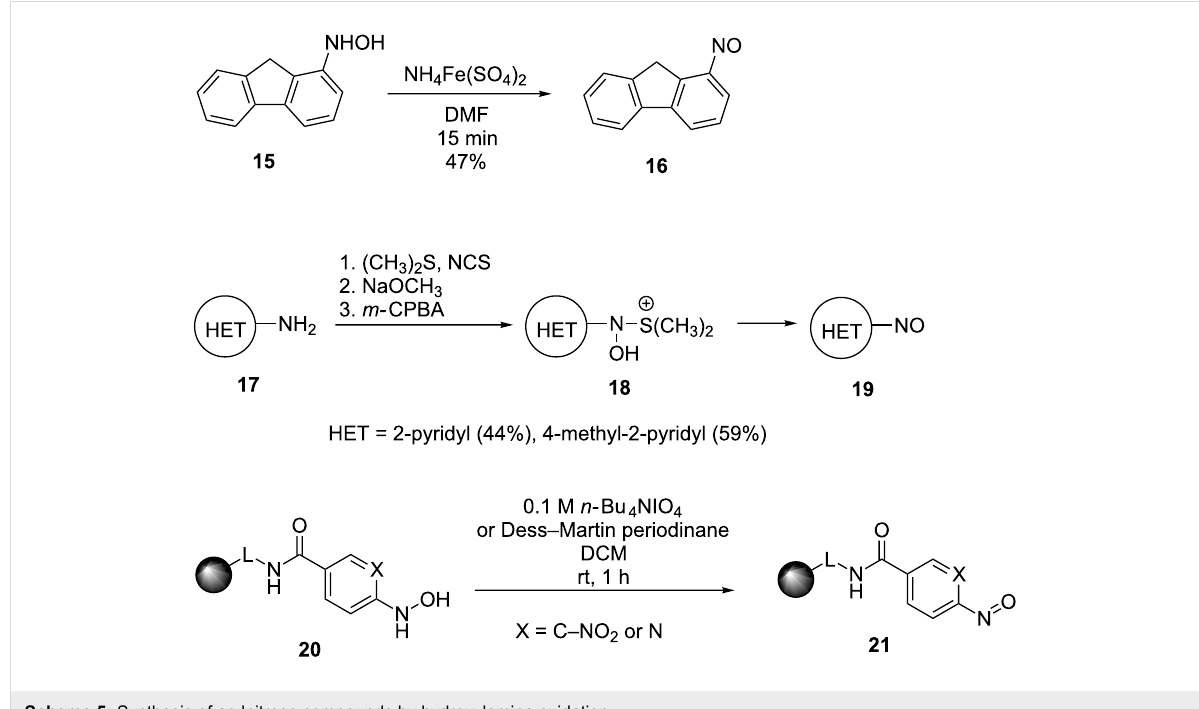
Scheme 5: Synthesis of arylnitroso compounds by hydroxylamine oxidation.